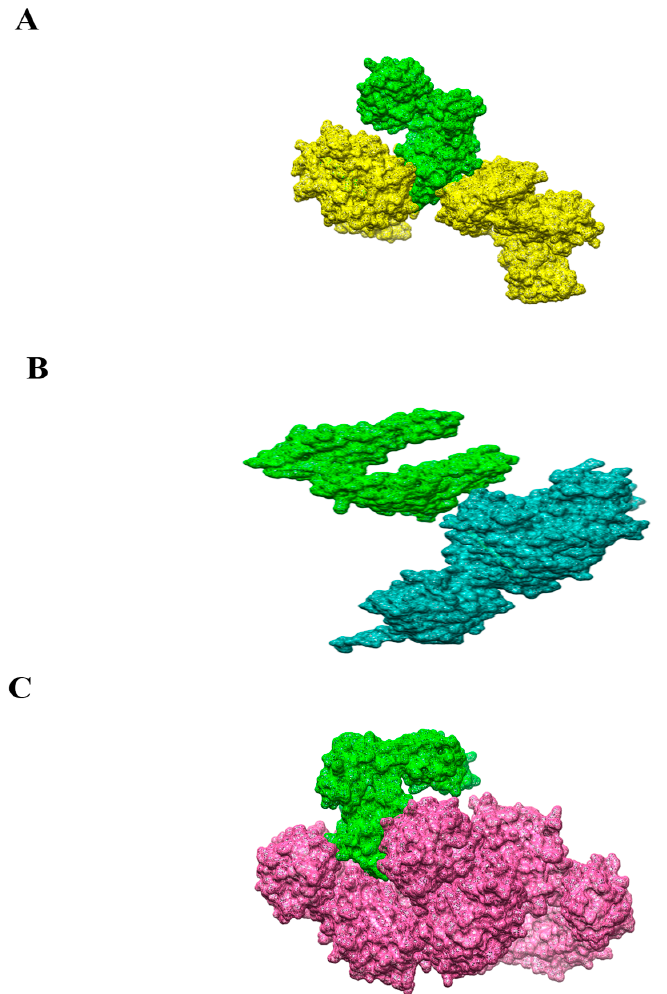
Figure 8. ( A ) 3D structure of the docked complex of chimeric vaccine (green mesh) and receptor MHC-I (yellow mesh). ( B ). 3D structure of the docked complex of chimeric vaccine (green mesh) and receptor MHC-I (dodger blue mesh). ( C ). 3D structure of the docked complex of chimeric vaccine (green mesh) and receptor MHC-I (magenta mesh).